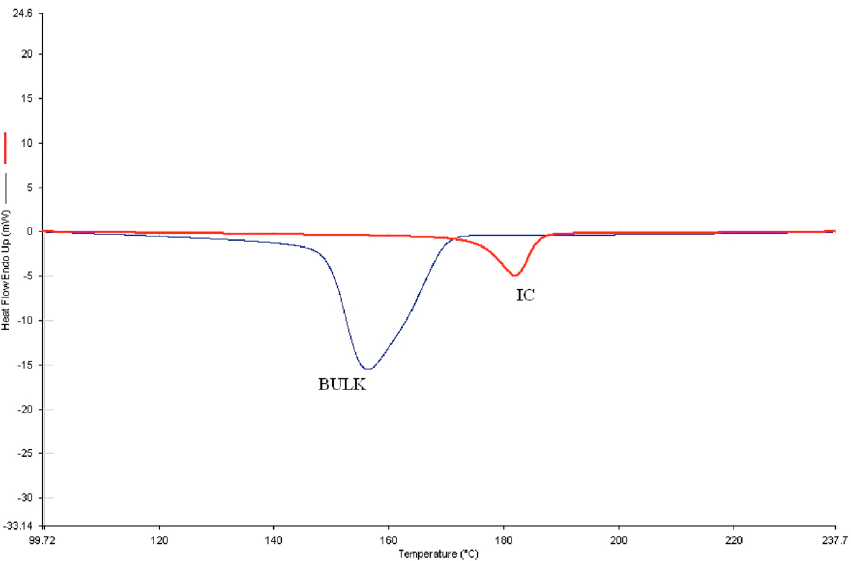
Figure 2. Differential scanning calorimetric (DSC) cooling scans (10 °C/min) from the melts of 600,000 g/mol bulk nylon-6 and its 3:1 (nylon-6: α –CD) (n-s) α –CD–IC, reproduced from [8] with permission, copyright American Chemical Society, 2009.